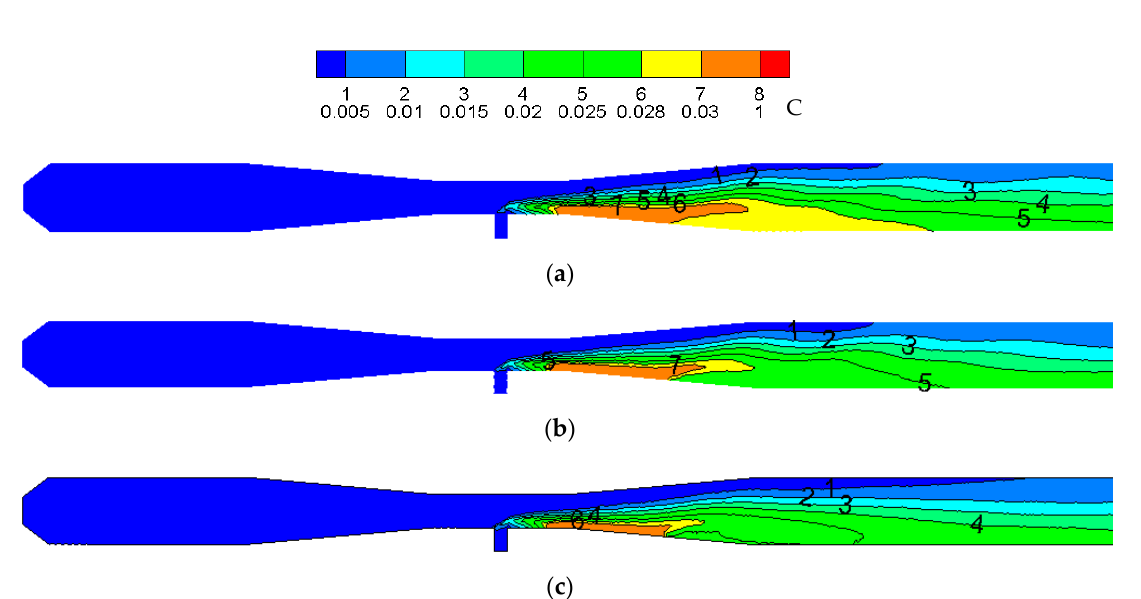
Figure 7. The comparison of concentration distribution of CeO 2 in the reactor after amplification: ( a ) magnified by 8 times ( b ) magnified by 10 times ( c ) magnified by 12 times.